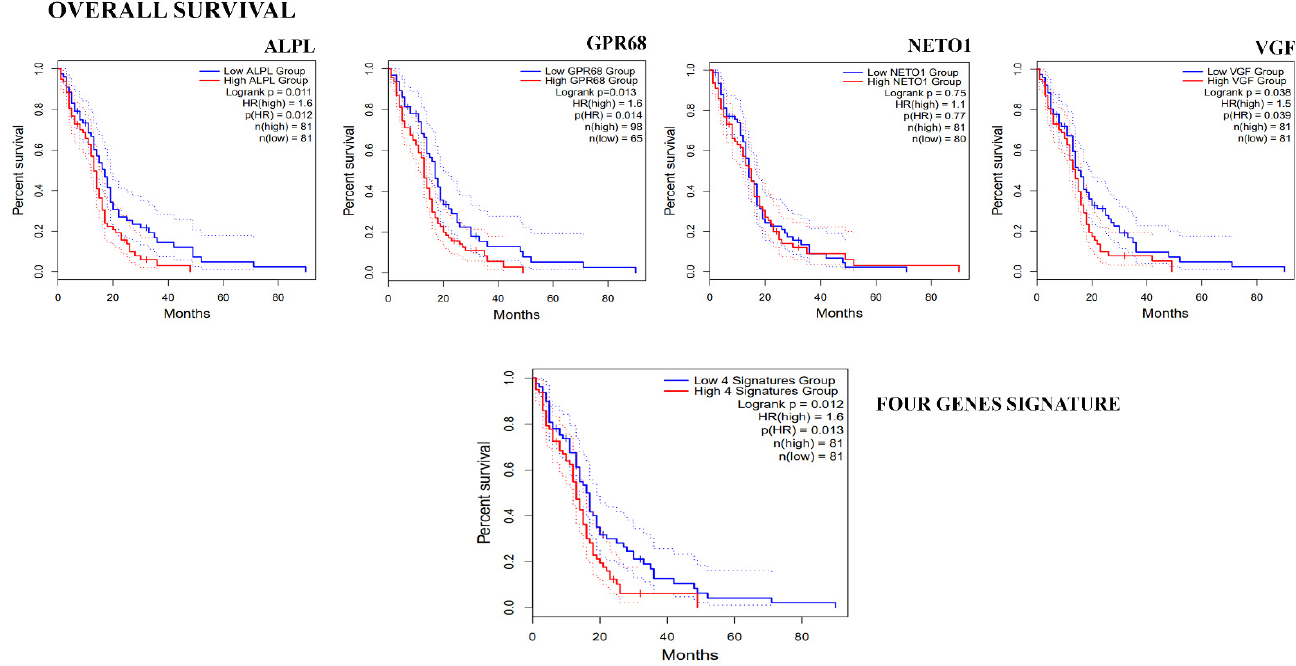
Figure 3. Clinical relevance of the 4 genes down-regulated in GASC-LS. The prognostic value of ALPL, GPR68, VGF, and NETO1 was assessed independently in the TCGA-GBM RNA-seq dataset evaluating the Overall Survival (OS) and was represented by Kaplan–Meier plots. Afterward, the analysis was repeated considering the four-genes signature (median expression). Patients were stratified based on the optimal cut-point.